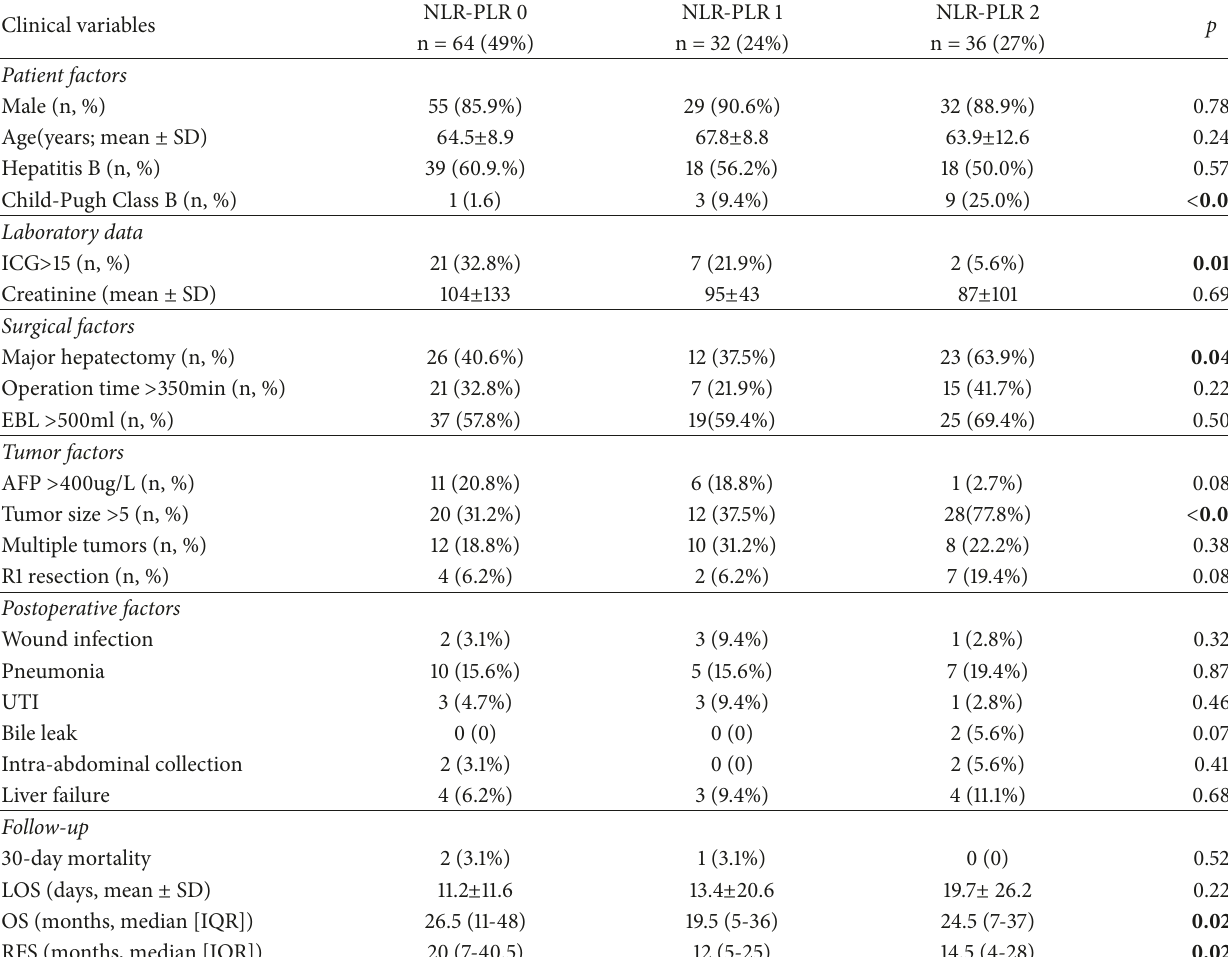
Table 4: Clinicopathological characteristics of patients undergoing curative hepatectomy for HCC. Clinical